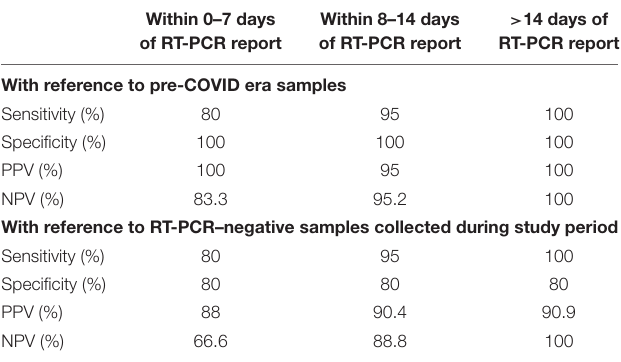
TABLE 3 | Accuracy indices of total antibody assay against nucleocapsid protein by ECLIA at 0–7, 8–14, and > 14 days of COVID diagnosis by RT-PCR with reference to pre-COVID era samples and RT-PCR–negative samples collected during the study period.